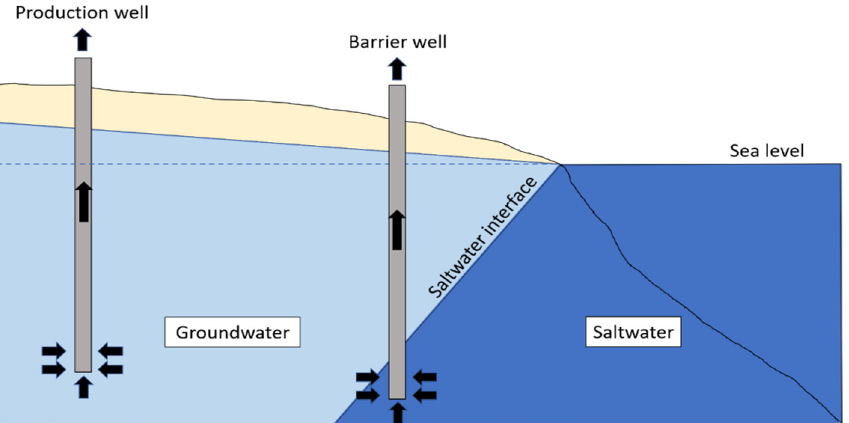
Figure 1. Conceptual diagram of saltwater pumping by a barrier well.